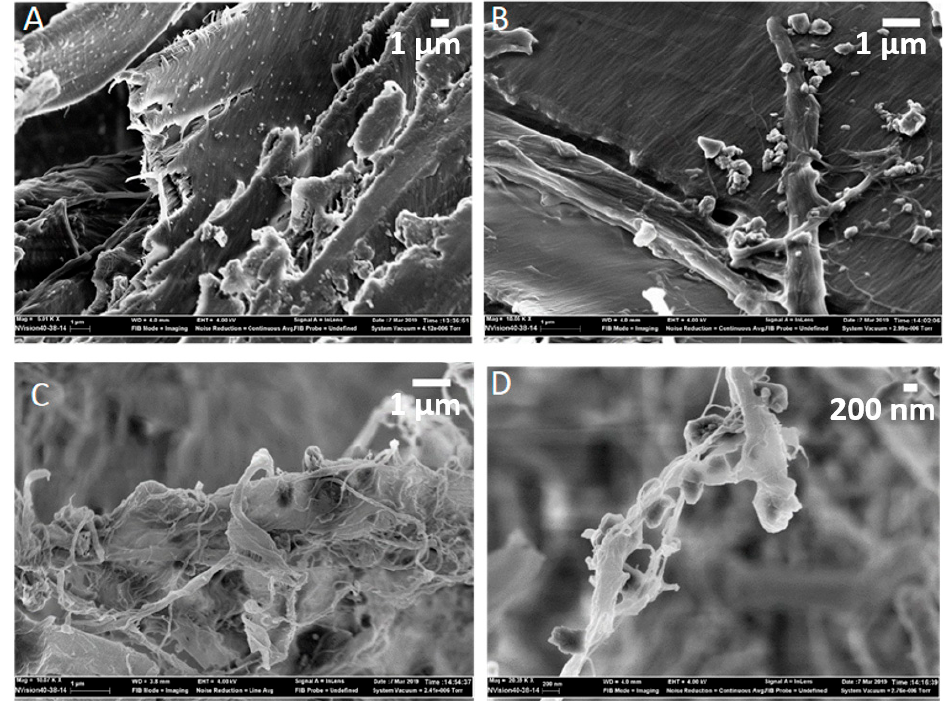
Figure 7. SEM of ( A , C ) fractured surfaces of panel samples without starch at a magnification of ×5000 and ×10,000, respectively, ( B , D ) panel samples with starch at a magnification of ×10,000 and ×20,000, respectively.